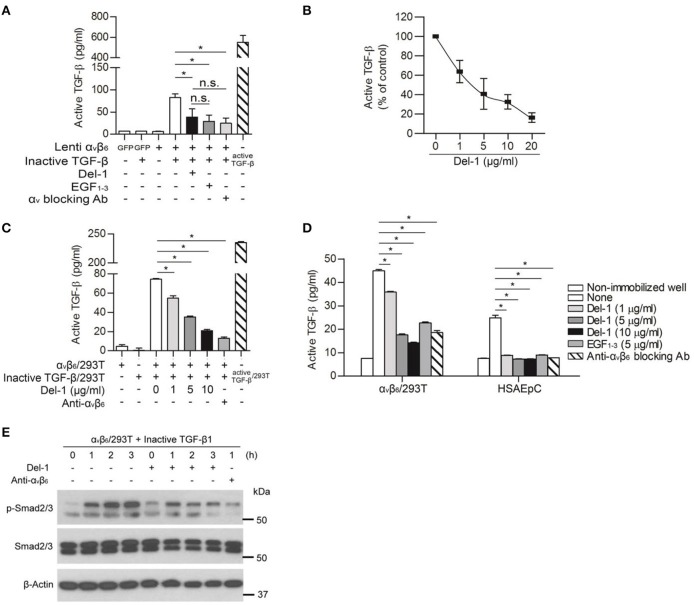
Del-1 inhibits αv integrin-mediated activation of TGF-β in vitro. (A) Activation of inactive TGF-β by αvβ6 integrin lentivirally expressed by HEK293T cells in the absence or presence of Del-1 (100 nM) or an αv-blocking antibody (2.2 μg/mL). Integrin αvβ6-overexpressing HEK293T cells (1 × 105/well) were plated and incubated overnight at 37°C. Conditioned medium from RAW264.7 cells overexpressing inactive TGF-β was then added in the presence of Del-1 or an αv-blocking antibody. EGF1−3 (10 μg/mL) was added to some wells instead of recombinant Del-1. After 12 h, active TGF-β levels were measured in an ELISA. Active TGF-β-containing supernatant was used as a positive control. Data are representative of three independent experiments, each with similar results, and are expressed as the mean ± SD (n = 3 per group). *p < 0.05; n.s., not significant; Mann-Whitney U-test. (B) Relative inhibition of αvβ6 integrin-mediated TGF-β activation by increasing concentrations of Del-1. αvβ6 integrin-overexpressing HEK293T cells (1 × 105/well) were plated and incubated overnight at 37°C. Conditioned medium from RAW264.7 cells overexpressing inactive TGF-β was added in the presence of Del-1 (0, 1, 5, 10, or 20 μg/mL). After 12 h of incubation, active TGF-β levels were measured in an ELISA. Data are presented as a percentage relative to the concentration of active TGF-β in the absence of Del-1, which was set to 100%. Data are representative of three independent experiments, each with similar results, and are expressed as the mean ± SD (n = 3 per group). Linear regression analysis revealed a significant inverse correlation between TGF-β activation and Del-1 concentration (p = 0.0002, R2 = 0.6301). (C) Inhibition of TGF-β activation in co-cultures of cells expressing either αvβ6 integrin or inactive TGF-β by increasing concentrations of Del-1. αvβ6 integrin-overexpressing HEK293T cells (2 × 104/well) and inactive TGF-β-expressing HEK293T cells (2 × 104/well) were plated and then incubated overnight at 37°C in the presence of Del-1 (0, 1, 5, or 10 μg/mL) or an αvβ6-blocking antibody (5 μg/mL). The supernatants were analyzed in an ELISA to measure active TGF-β. Data are expressed as the mean ± SD (n = 3 per group). *p < 0.05; Mann-Whitney U-test. (D) Inhibition of TGF-β activation by Del-1 in αvβ6 integrin-overexpressing HEK293T cells or primary epithelial cells exposed to immobilized inactive TGF-β. Conditioned medium from RAW264.7 cells overexpressing inactive TGF-β were coated onto the plate, and then αvβ6 integrin-overexpressing HEK293T cells or HSAEpCs were plated in the presence of Del-1, EGF1−3, or an αvβ6-blocking antibody. After an overnight incubation at 37°C, active TGF-β levels were measured in an ELISA. Data are representative of three independent experiments, each with similar results, and are expressed as the mean ± SD (n = 3 per group). *p < 0.05; Mann-Whitney U-test. (E) Del-1-mediated reduction in the amount of active TGF-β to weaken TGF-β signaling in cells. Representative western blots showing phospho-Smad2/3 in HEK 293T cells overexpressing αvβ6 integrin in response to inactive TGF-β. Cells were incubated at 37°C with a RAW 264.7 cell-derived conditioned medium containing inactive TGF-β in the presence of Del-1 for 1–3 h, or in the presence of an αvβ6-blocking antibody for 1 h. Data are derived from three independent experiments.